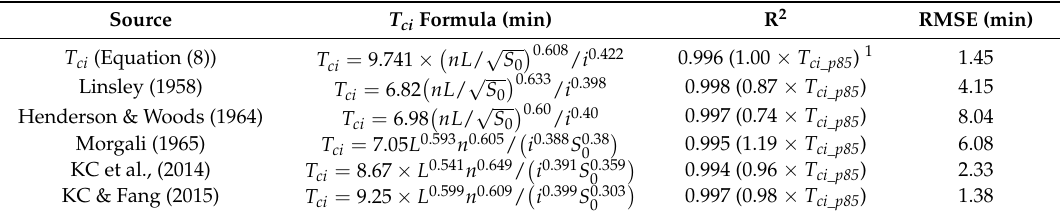
Table 2. Six T ci equations and statistical results when compared with simulated T ci_p85 (Figure 5). Source T ci Formula